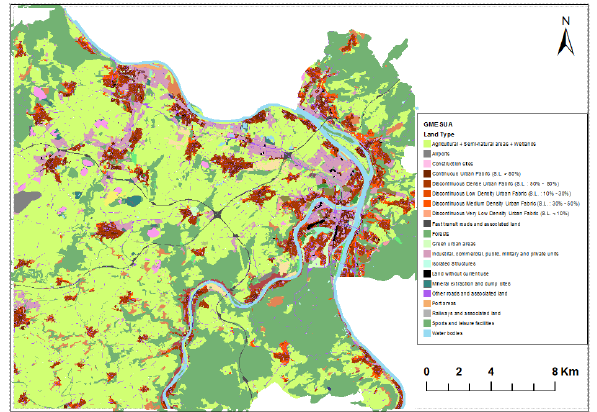
Figure 3: Global Monitoring for Environment and Security Urban Atlas (GMESUA) land use map (European Union,